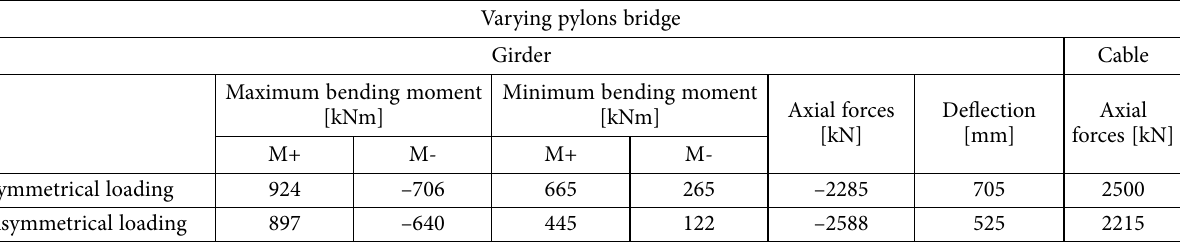
Table 3. Varying pylons bridge elements stresses